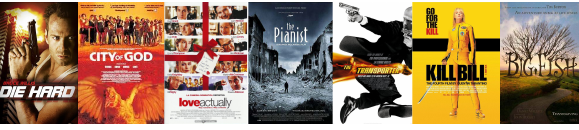
Figure 8. Examples of items in the Yahoo